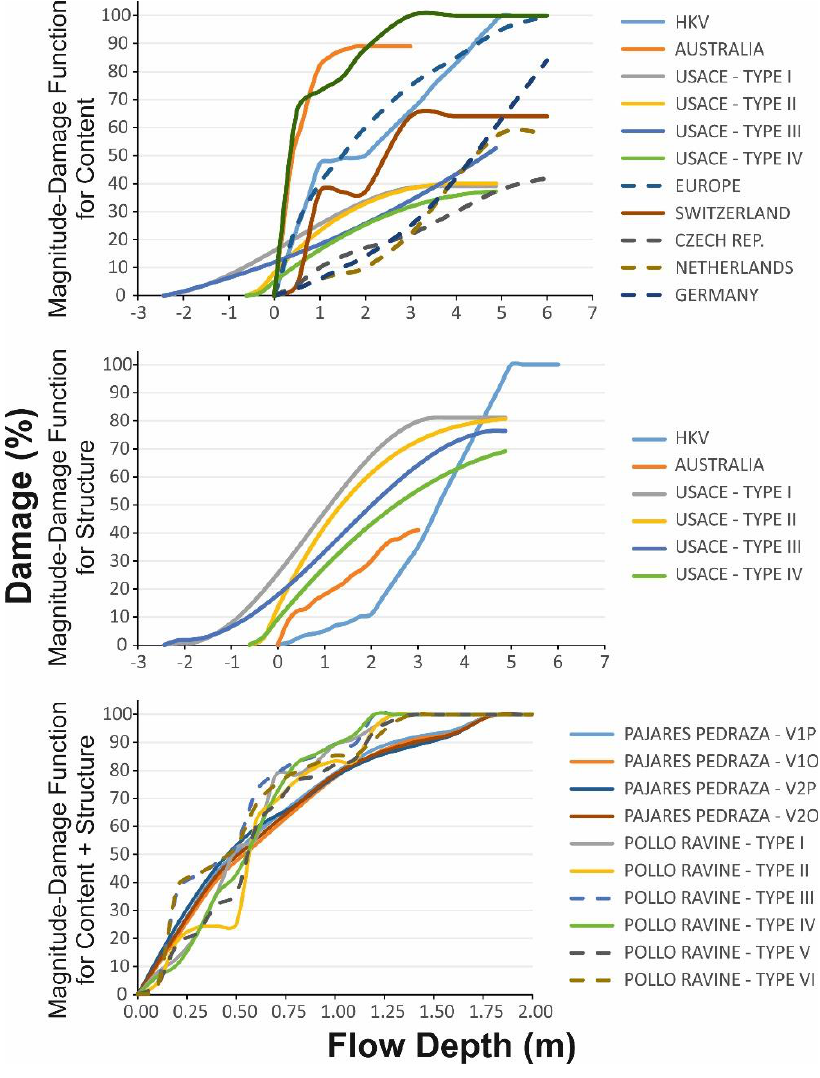
Figure 1. Magnitude–damage models used. The models are classified in relation to their consideration of content, structure, or content + structure.